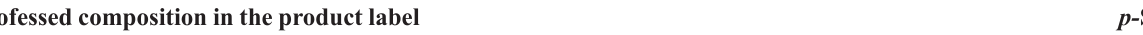
TABLE I – Listing of samples of teas containing Citrus aurantium , commercialized in supermarkets of Porto Alegre and analyzed respecting to presence of p -synephrine ( p -SIN) Professed composition in the product